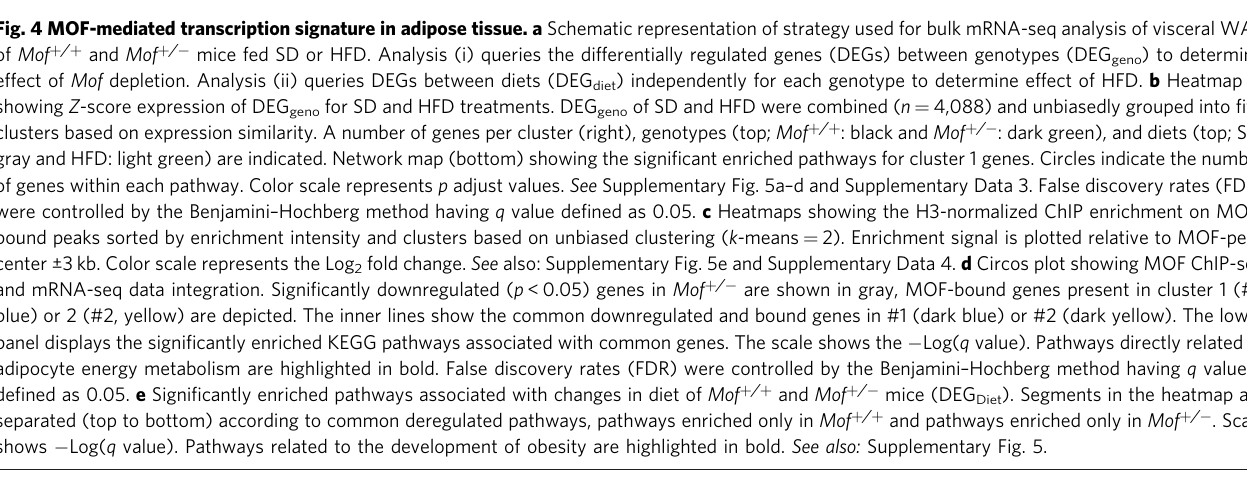
Fig. 4 MOF-mediated transcription signature in adipose tissue. a Schematic representation of strategy used for bulk mRNA-seq analysis of visceral WAT of Mof + / + and Mof + / − mice fed SD or HFD. Analysis (i) queries the differentially regulated genes (DEGs) between genotypes (DEG geno ) to determine effect of Mof depletion. Analysis (ii) queries DEGs between diets (DEG diet ) independently for each genotype to determine effect of HFD. b